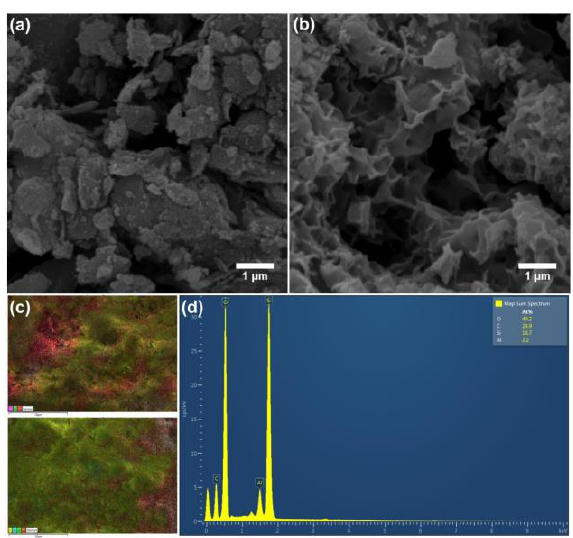
Fig. 3 SEM images of (a) MMt and (b) sMMt. (c) Images of elemental mapping of MMt (up; each colour indicates for Al (purple), O (green), and Si (red) atoms) and sMMt (bottom; each colour indicates Al (blue), O (green), Si (red), and C (yellow) atoms). (d) EDX spectra of sMMt